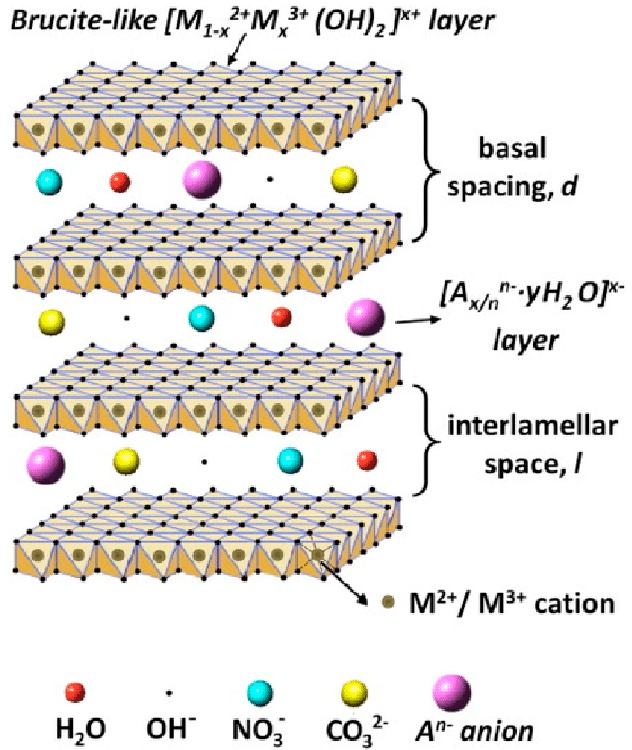
Figure 1. General chemical structure of layered double hydroxides (LDHs). Adapted from Scarpellini, D., Falconi, C., Gaudio, P., Mattoccia, A., Medaglia, P.G., Orsini, A., Pizzoferrato, R., Richetta, M.,